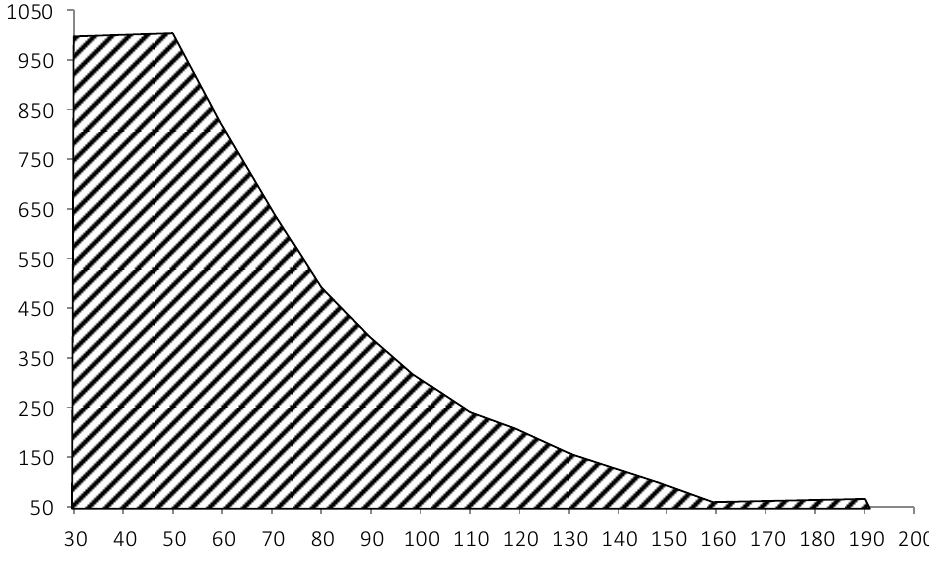
Figure 6. Target values of secondary coil ‐ circuit current intensity and duration of the spark achiev ‐ able by the ignition system.